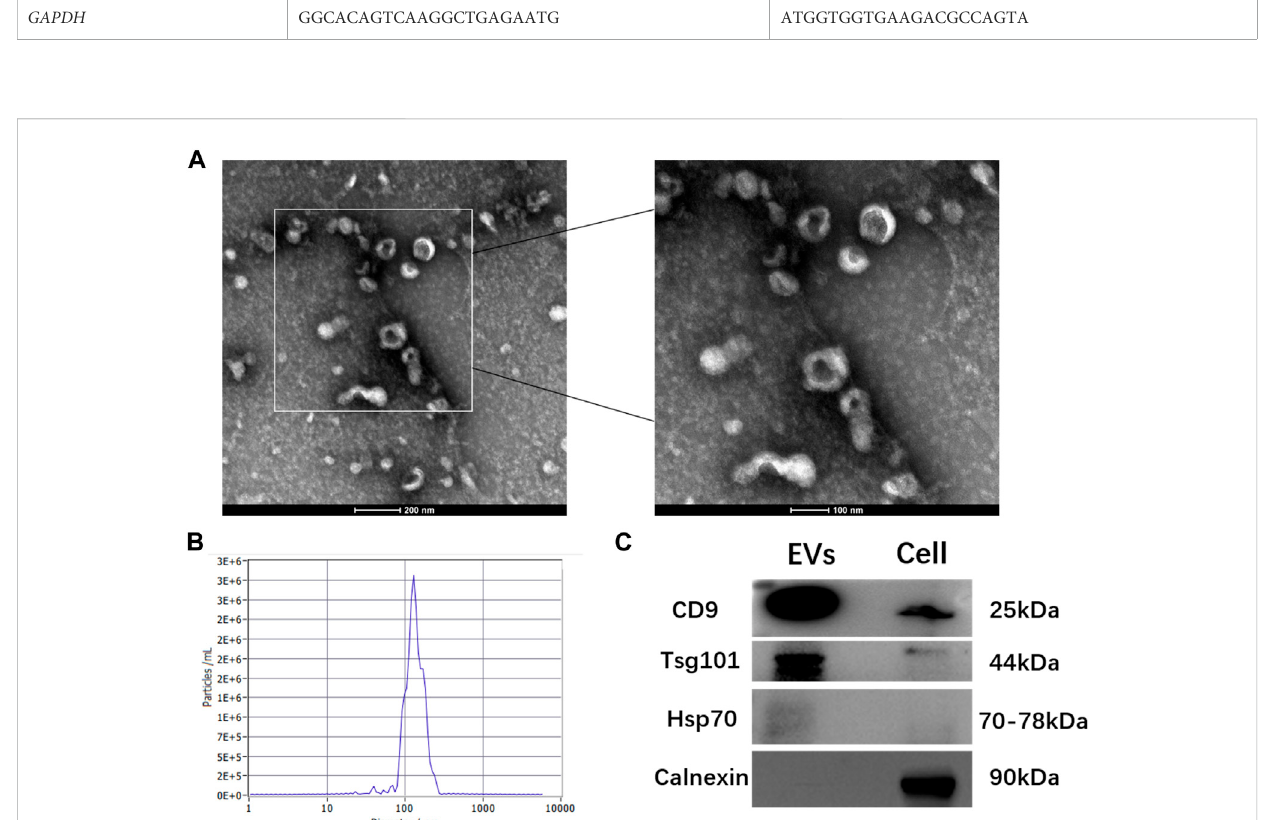
FIGURE 1 Characterization of hGMSC-derived EVs (A) hGMSC-derived EVs morphology observed by TEM (B) Particle size distribution of hGMSC-derived EVs detected by NTA (C) Western blotting results of the EVs surface markers CD9, Tsg101, and Hsp